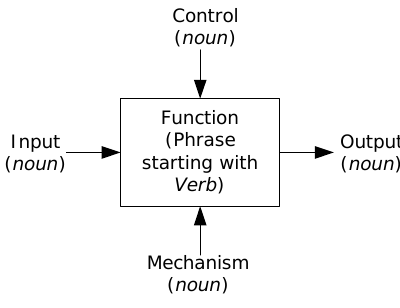
Figure 2. “IDEF0 function modeling